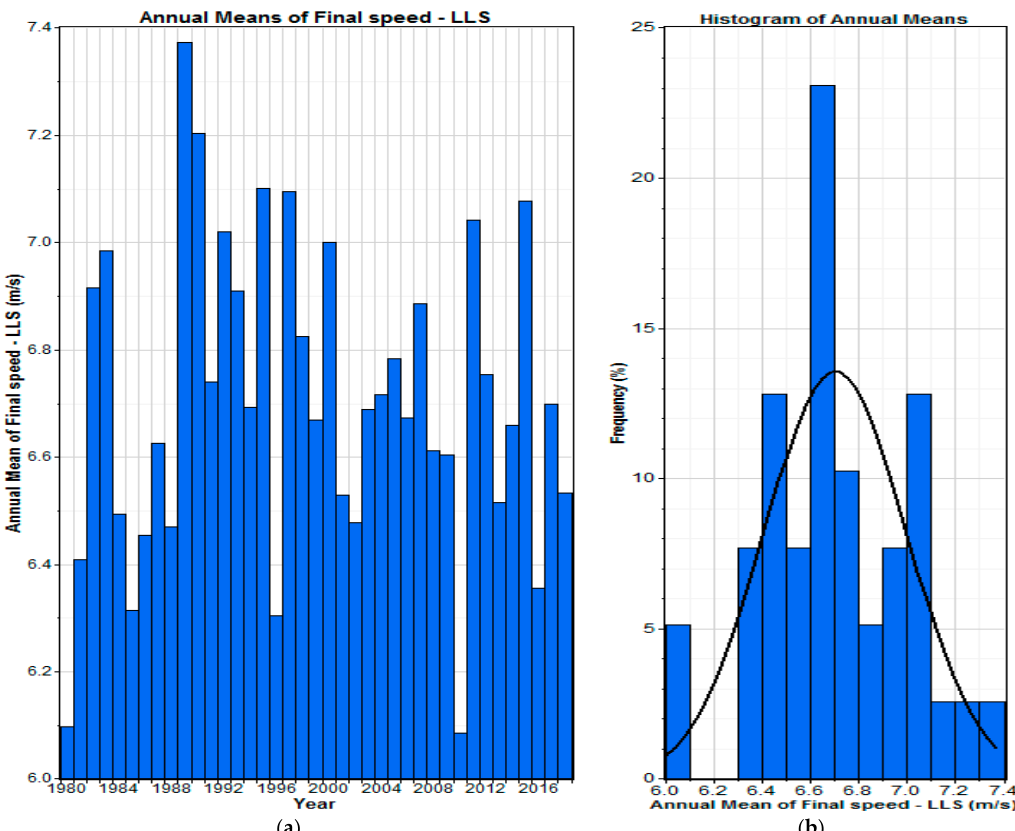
Figure 13. Multi-annual predicted wind speed of the wind farm: ( a ) Annual mean wind speed of 38 years; ( b ) Histogram of annual means.